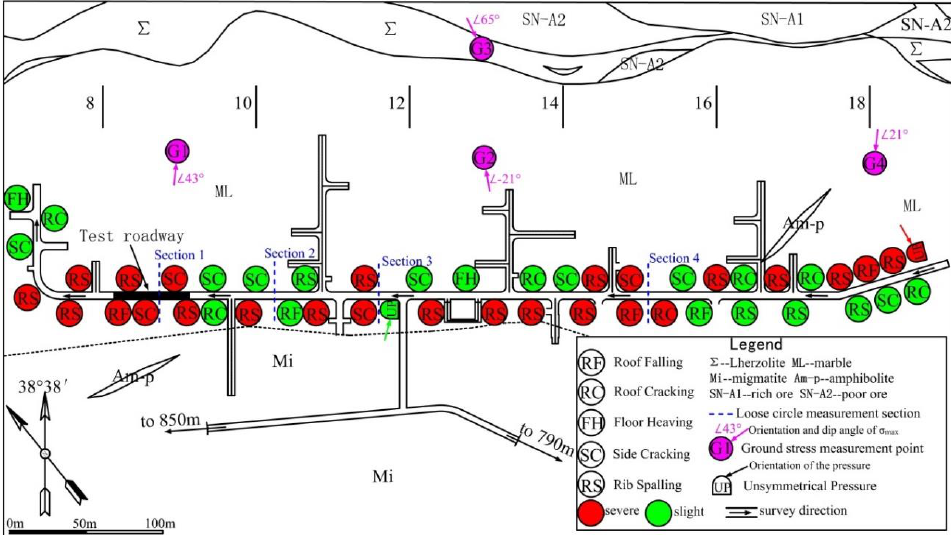
Figure 4. Field investigation of the panel at the burial depth of approximately 1000 m.